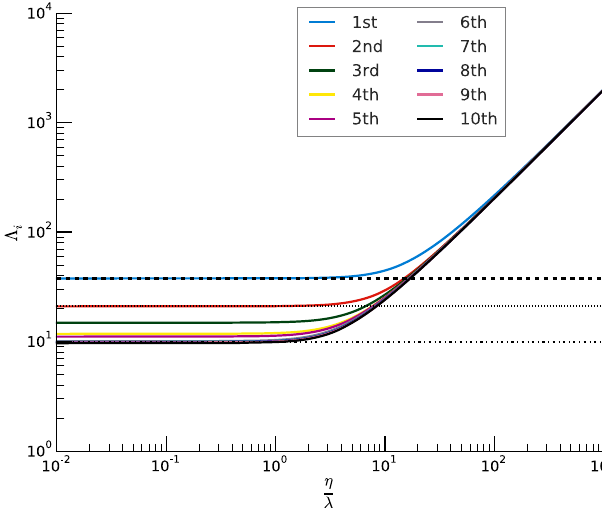
FIG. 16. Evaluation of the eight first eigenvalues of R ð λ ; η Þ for the multiplex configuration as a function of the ratio η = λ . It is noteworthy that such a plot is visually equivalent for all the layer topologies composed of three layers. The dashed lines represent the individual-layer leading eigenvalues.